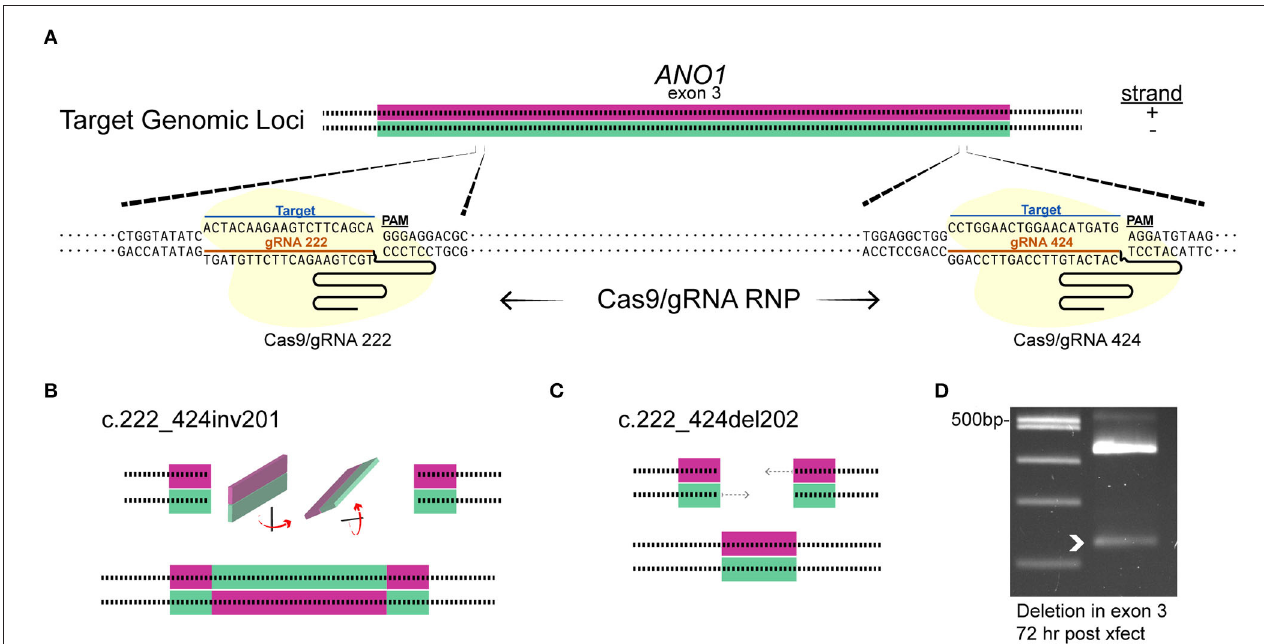
FIGURE 6 | Targeting TMEM16A exon 3 with dual gRNA Cas9 ribonucleoprotein produces deletions within 3 days. (A) The target loci in TMEM16A showing cleavage sites. (B,C) Graphical depictions of observed mutations from single amacrine cells that were dual gRNA-transfected showing an inversion c.222_424inv201 (B) and deletion c.222_424del202 (C) between the two target sites. (D) Edits were present as a smaller PCR amplicon from a separate amplification of mixed cultures 3 days post-transfection (white